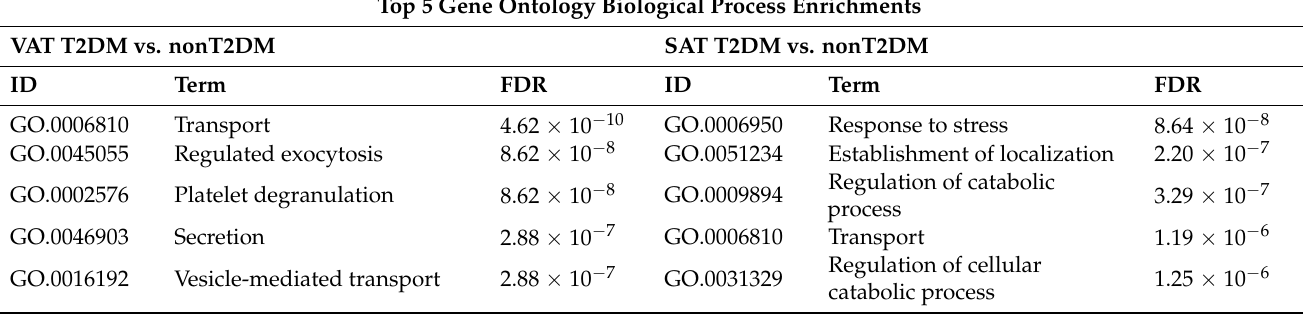
Table 6. Top 5 Gene Ontology biological process enrichments for type 2 diabetes mellitus differential expression networks for visceral and subcutaneous white adipose tissue depots. Top 5 Gene Ontology Biological Process